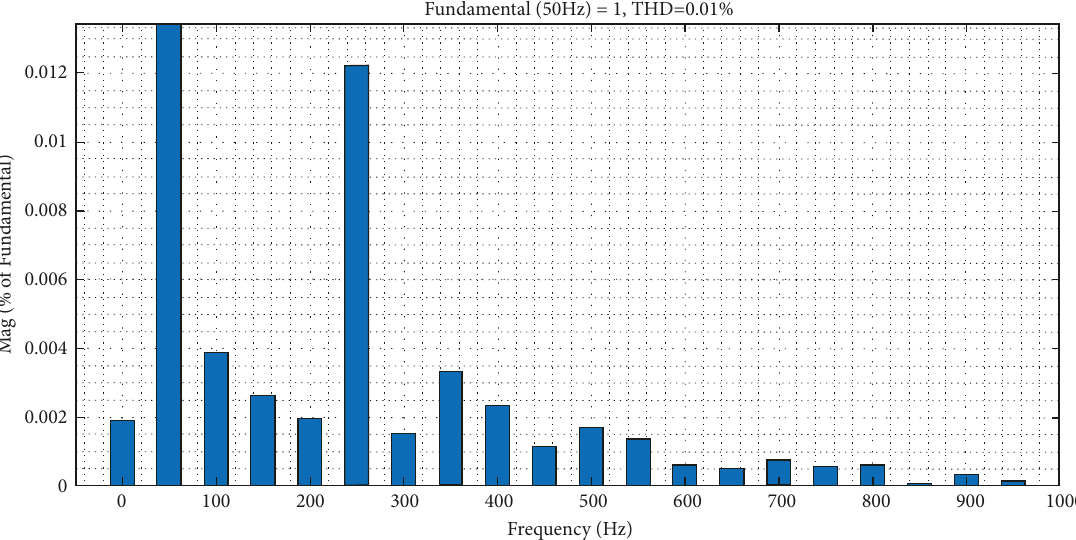
Figure 8: Voltage THD of AC grid side for PI with level-shifted